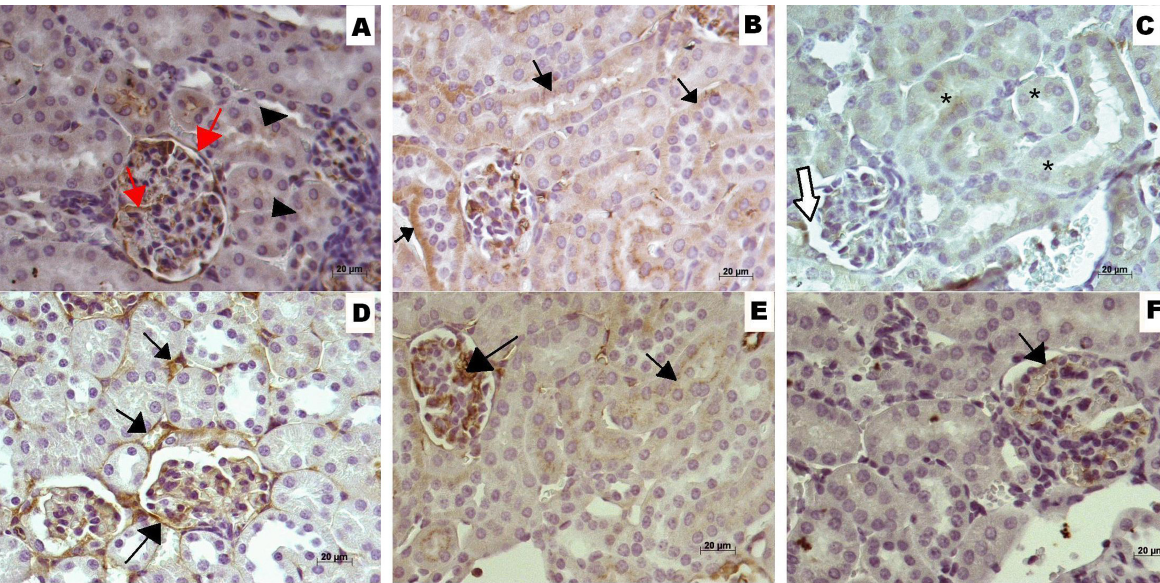
Figure 3. Immunohistochemical staining for endostatin and CD31, in normal (A and D) and endotoxemic (B, C, E, and F) mouse kidneys. A , Diffuse cytoplasmic staining for endostatin in proximal and distal tubules (arrowheads); endostatin staining is positive in the basement membrane of Bowman’s capsule and in endothelial cells of the glomerular capillaries (red arrow); B , kidney 4 h after LPS inoculation showing strong staining of the tubular basement membranes (arrows); C , kidney 12 h after LPS inoculation showing moderate staining for endostatin in proximal and distal tubules (asterisks) and in a glomerulus (thick arrow); D , CD31-positive in peri- tubular arterioles, in the basement membrane of Bowman’s capsule and in glomerular endothelial cells (arrows); E , kidney 4 h after LPS inoculation showing moderate and diffuse staining of tubular cells (arrows); F , kidney 12 h after LPS inoculation showing minimal tubular and glomerular (arrow) staining. Magnification: 40X.